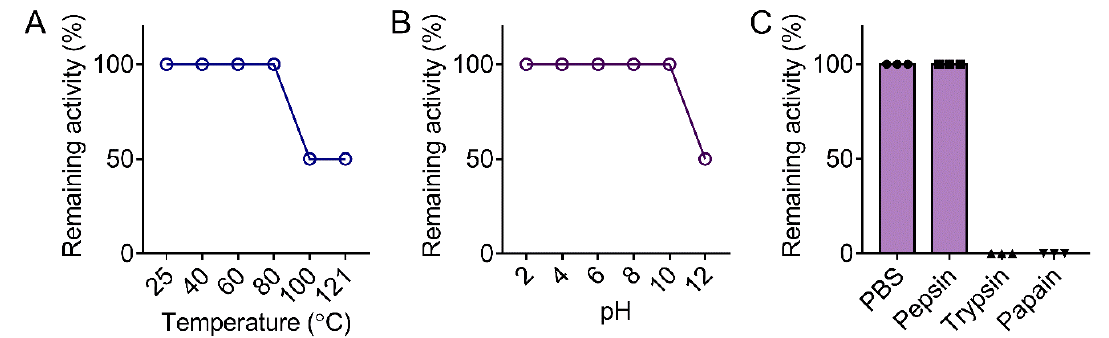
Figure 4. Thermal, pH and proteolytic stability of WRK-12 against E. coli 1F28. Remaining activity (%) of WRK-12 against E. coli 1F28 after treatment with varying temperature ( A , from 25 to 121 ◦ C), pH ( B , from 2 to 12) and three proteases ( C ).